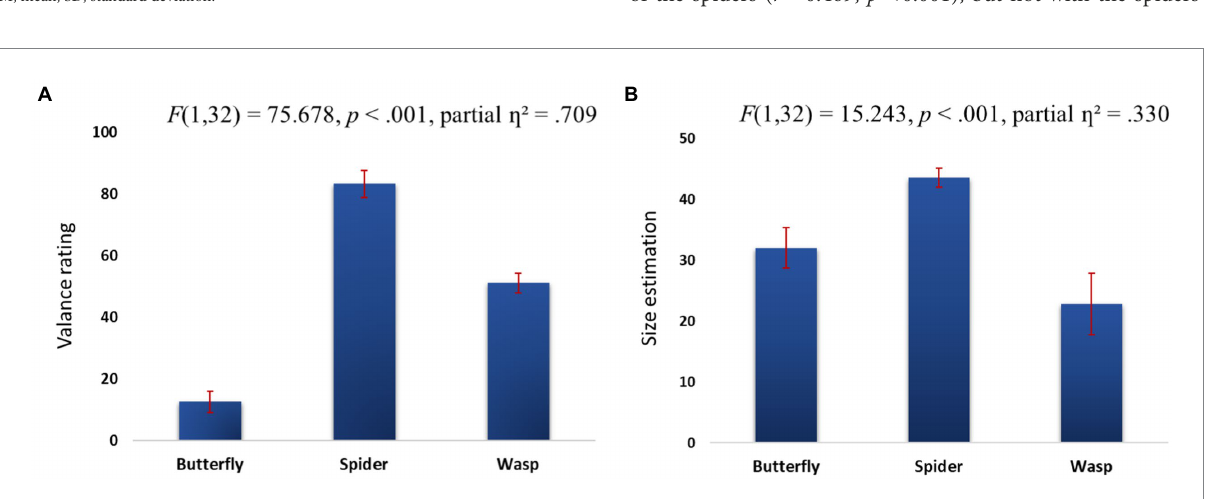
FIGURE 2 Valence ratings (A) and size estimation (B) for butterflies, spiders, and wasps. Vertical lines represent standard